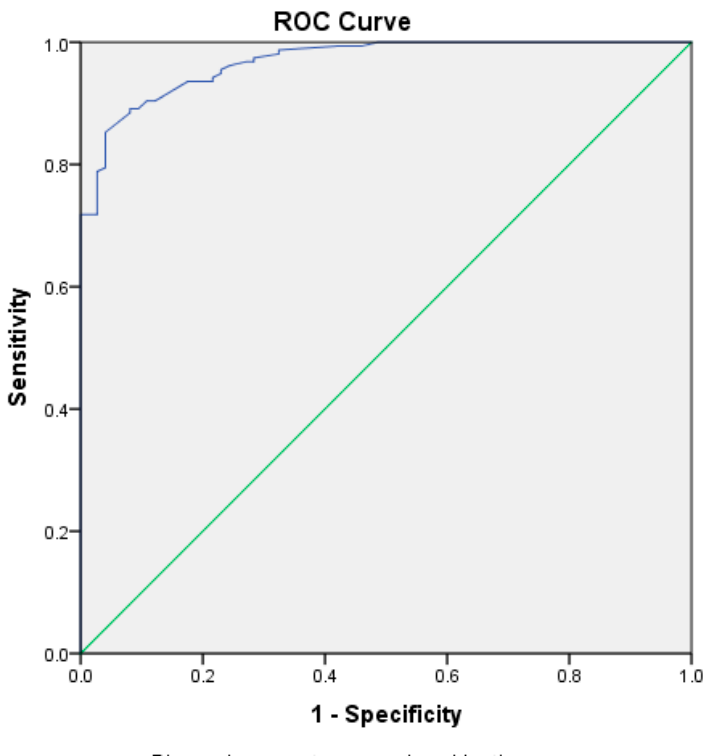
Figure 1. ROC curve. The area under the curve is 0.96. The model can accurately discriminate 96% of the cases.